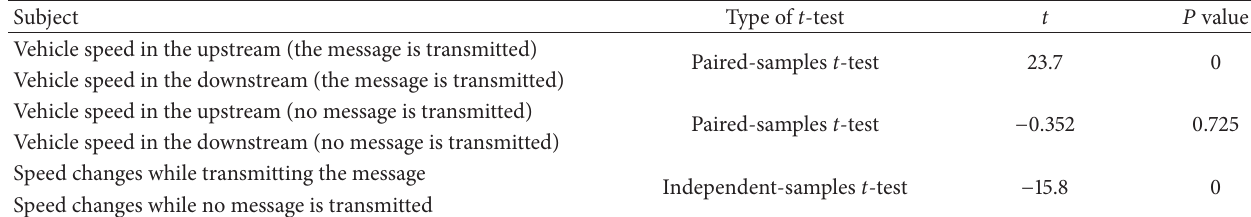
Table 7: Result of Student’s t -test for comparing the speed in the upstream and downstream while transmitting a message and no message